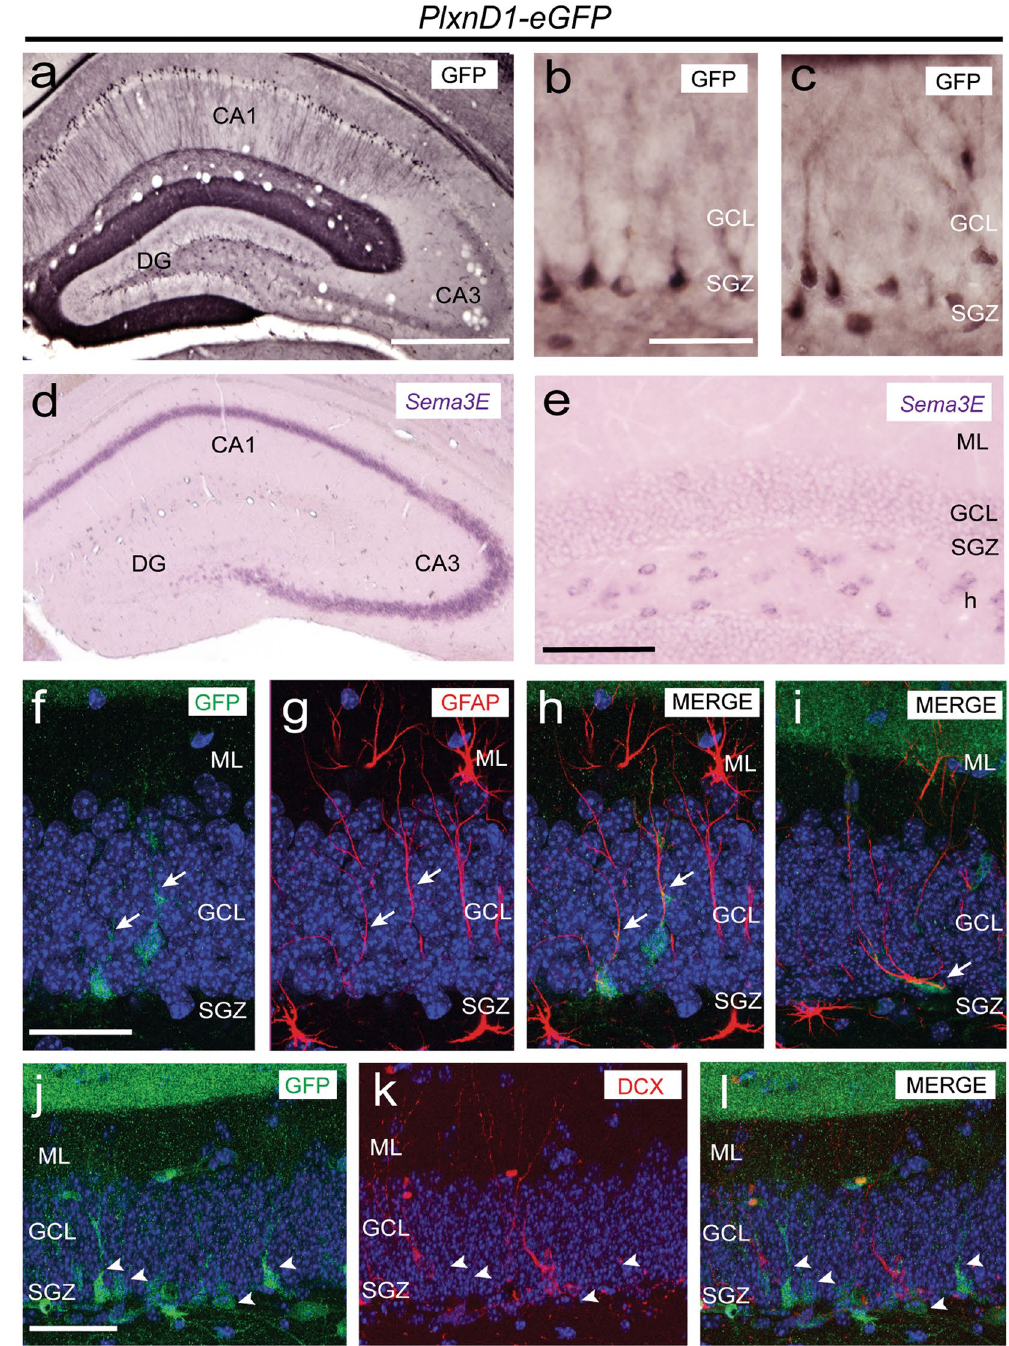
Figure 5. Low- (a ) and high- ( b,c ) power photomicrographs illustrating GFP-positive neurons in the hippocampus ( a ) and dentate gyrus ( b,c ) of adult PlxnD1-eGFP mice. Note GFP labelling in subsets of pyramidal neurons CA1 and cells of hilus and subgranular zone. Low- ( d ) and high- ( e ) power photomicrographs illustrating the distribution of Sema3E mRNA in the hippocampus ( d ) and dentate gyrus ( e ) of adult wild-type mice. ( f – i ) Confocal immunofluorescence images for GFP (green) and GFAP (red) in the dentate gyrus of adult PlxnD1-eGFP mice. Note that all GFP-positive cells express GFAP marker (arrows). ( j – l ) Confocal immunofluorescence images for GFP (green) and DCX (red) in the dentate gyrus of adult PlxnD1- eGFP mice. Note that not all GFP-positive cells express DCX marker (arrowheads). Abbreviations as in Figs 1–4 and ML = molecular layer; SGZ = subgranular zone. Scale bars: a = 500 µ m pertains to d ; b = 50 µ m pertains to c ; e = 150 µ m; f = 50 µ m pertains to ( g – i ); j = 50 µ m pertains to ( k , l